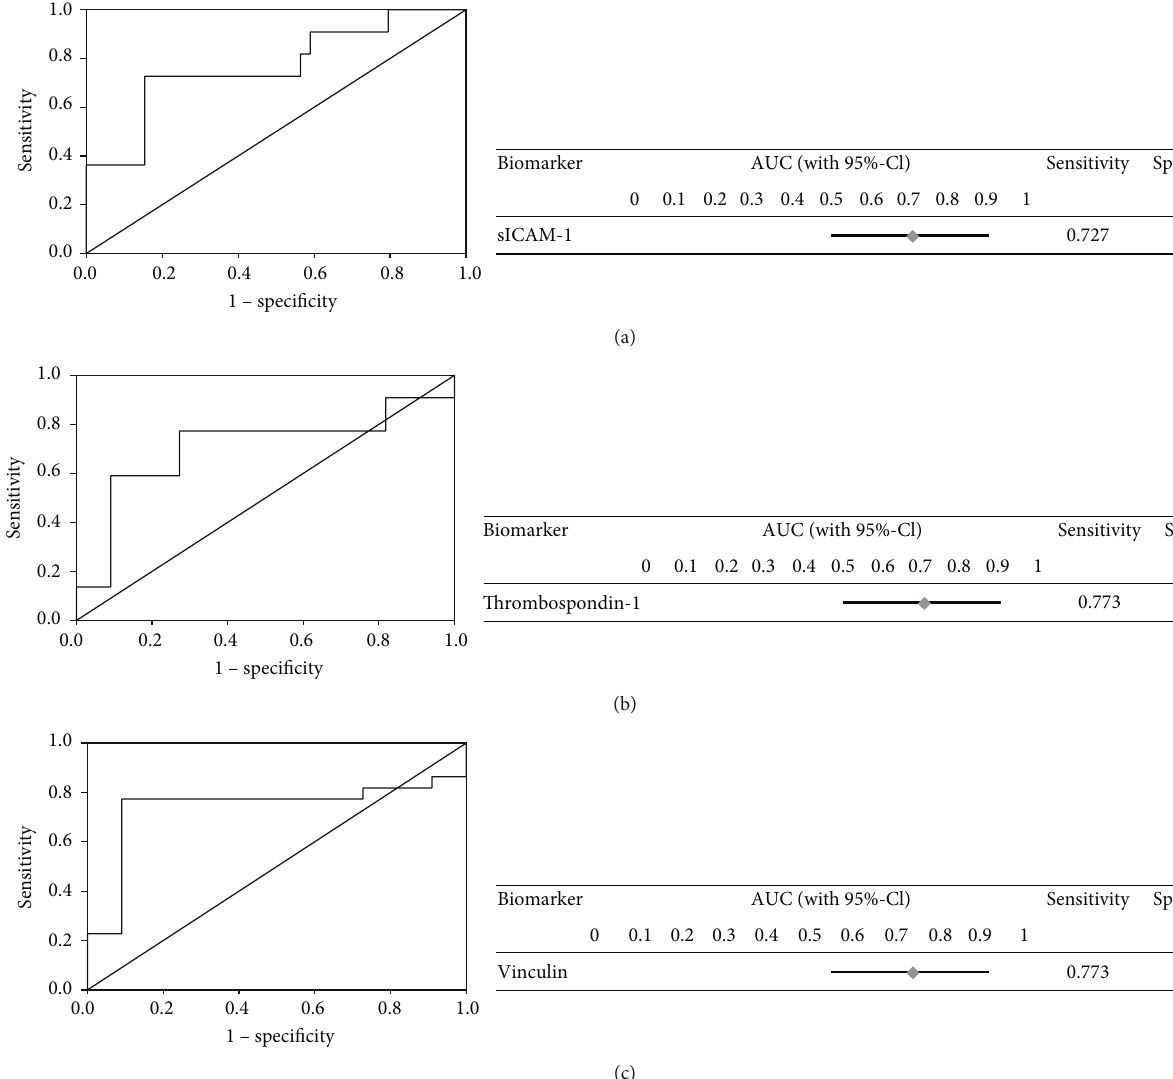
Figure 2: Receiver operating characteristic (ROC) analyses for sICAM-1, thrombospondin-1, and vinculin for IFI diagnosis at fi rst detection of fungal pathogens. (a) ROC analysis for sICAM-1 in fungal-infected vs. fungal-colonized patients at fi rst detection of fungal pathogens. Abbreviations: AUC: area under the curve; CI: con fi dence interval. (b) ROC analysis for thrombospondin-1 in fungal-infected vs. fungal- colonized patients at fi rst detection of fungal pathogens. Abbreviations: AUC: area under the curve; CI: con fi dence interval. (c) ROC analysis for vinculin in fungal-infected vs. fungal-colonized patients at fi rst detection of fungal pathogens. Abbreviations: AUC: area under the curve; CI: con fi dence